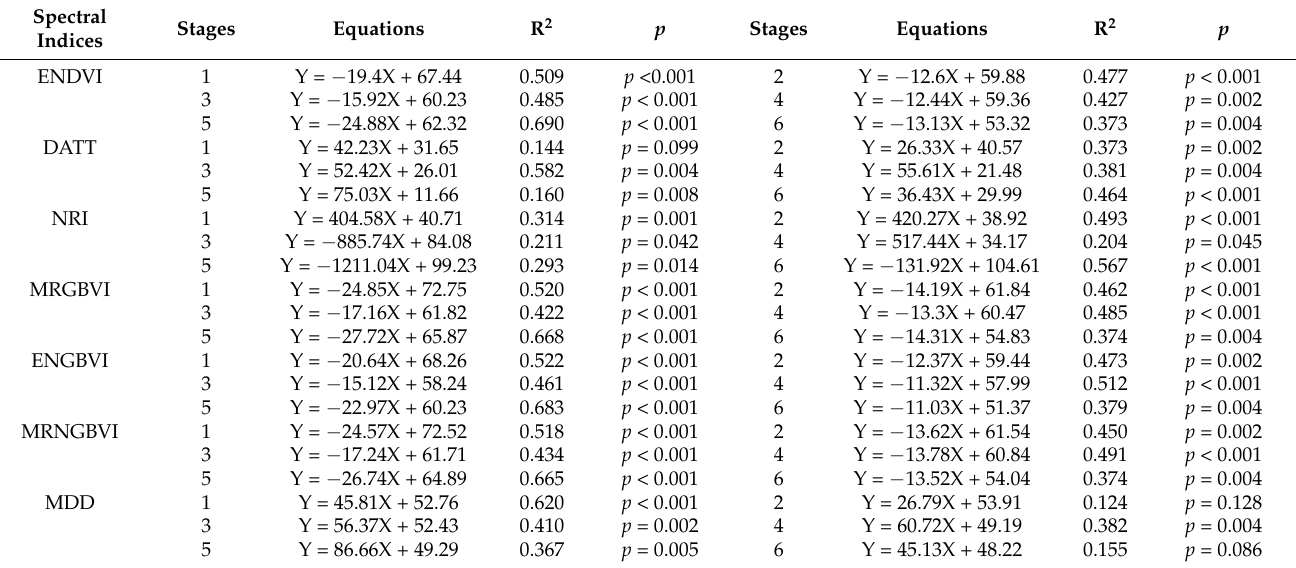
Table A2. The result of linear regression analysis between SIs and SPAD values for different growth stages. The spectral indices mean different information, and the stages are in according with the date of data acquisition in Figure 3. The Equation represents the linear regression equation, R 2 means the coefficient of determination, and the p means the significant values.